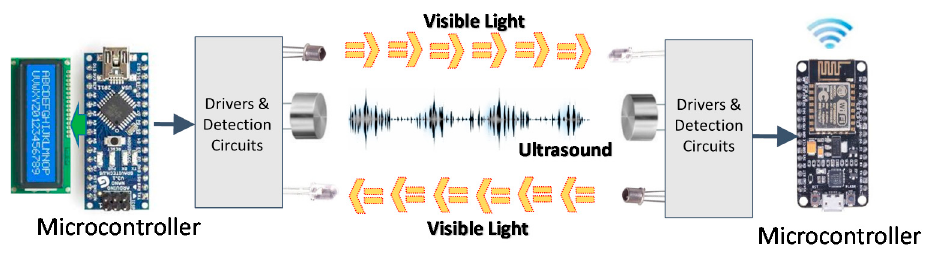
Figure 4. Operational scheme of the proposed system.